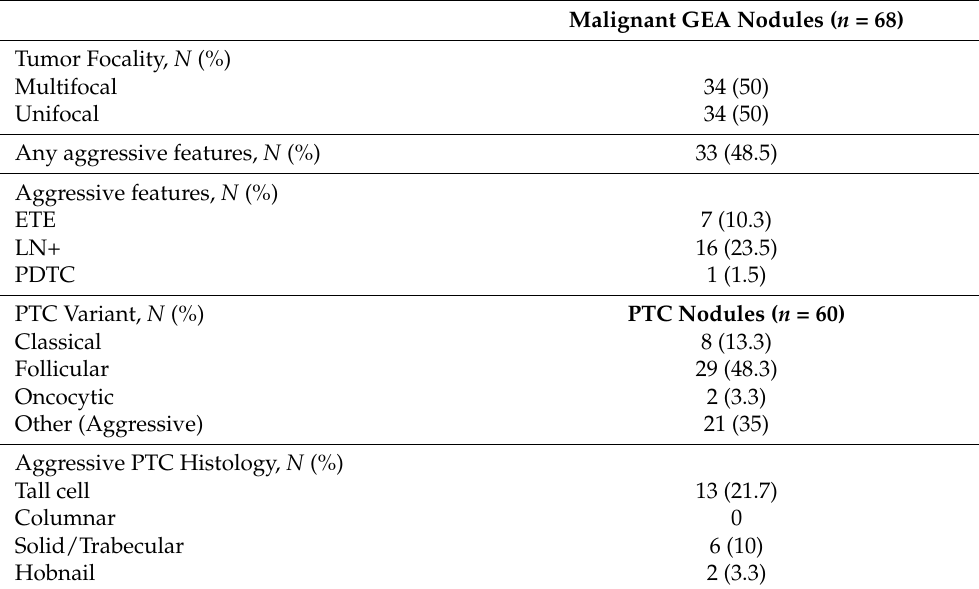
Table 3. Oncologic Features of Malignant Gene Expression Profile Positive Thyroid